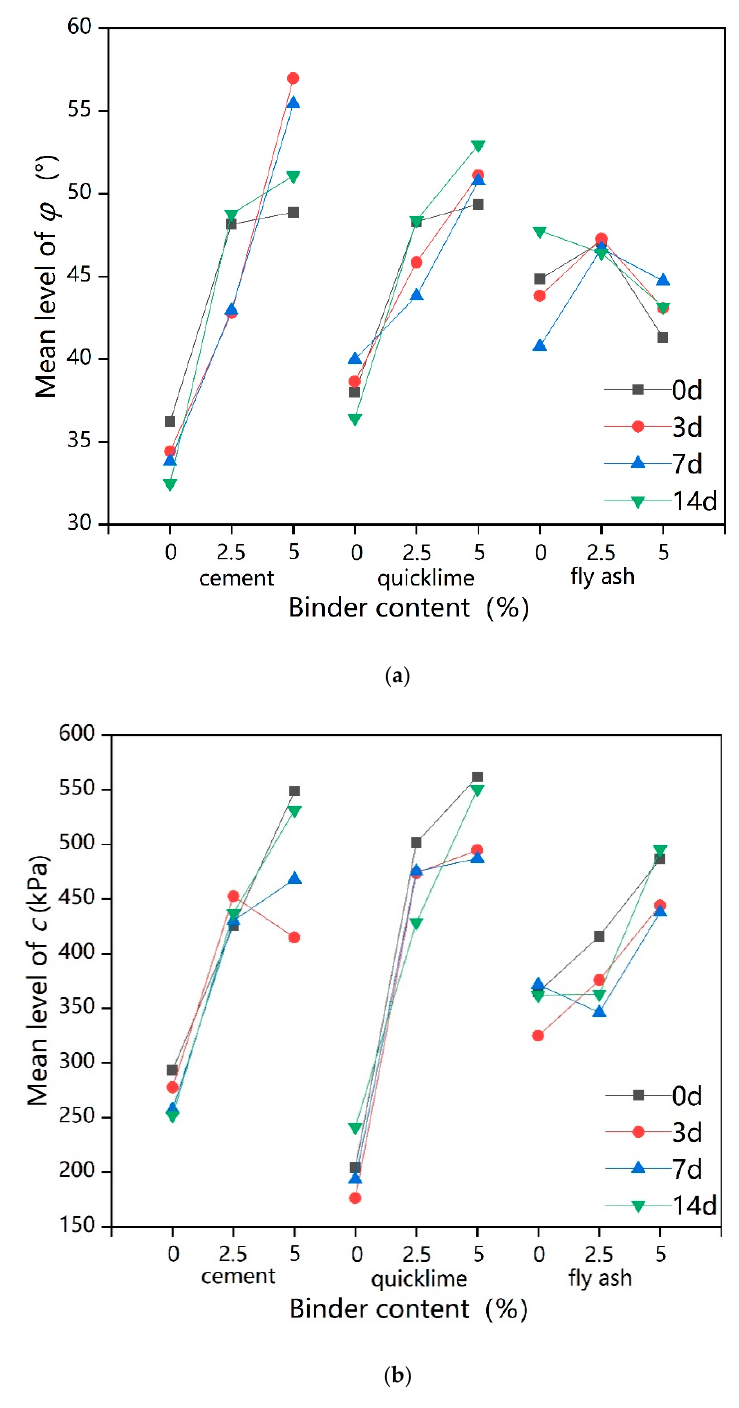
Figure 9. Intuitive trend chart of influencing factors for the shear index: ( a ) Intuitive trend chart of influencing factors for ϕ ; ( b ) Intuitive trend chart of influencing factors for c .